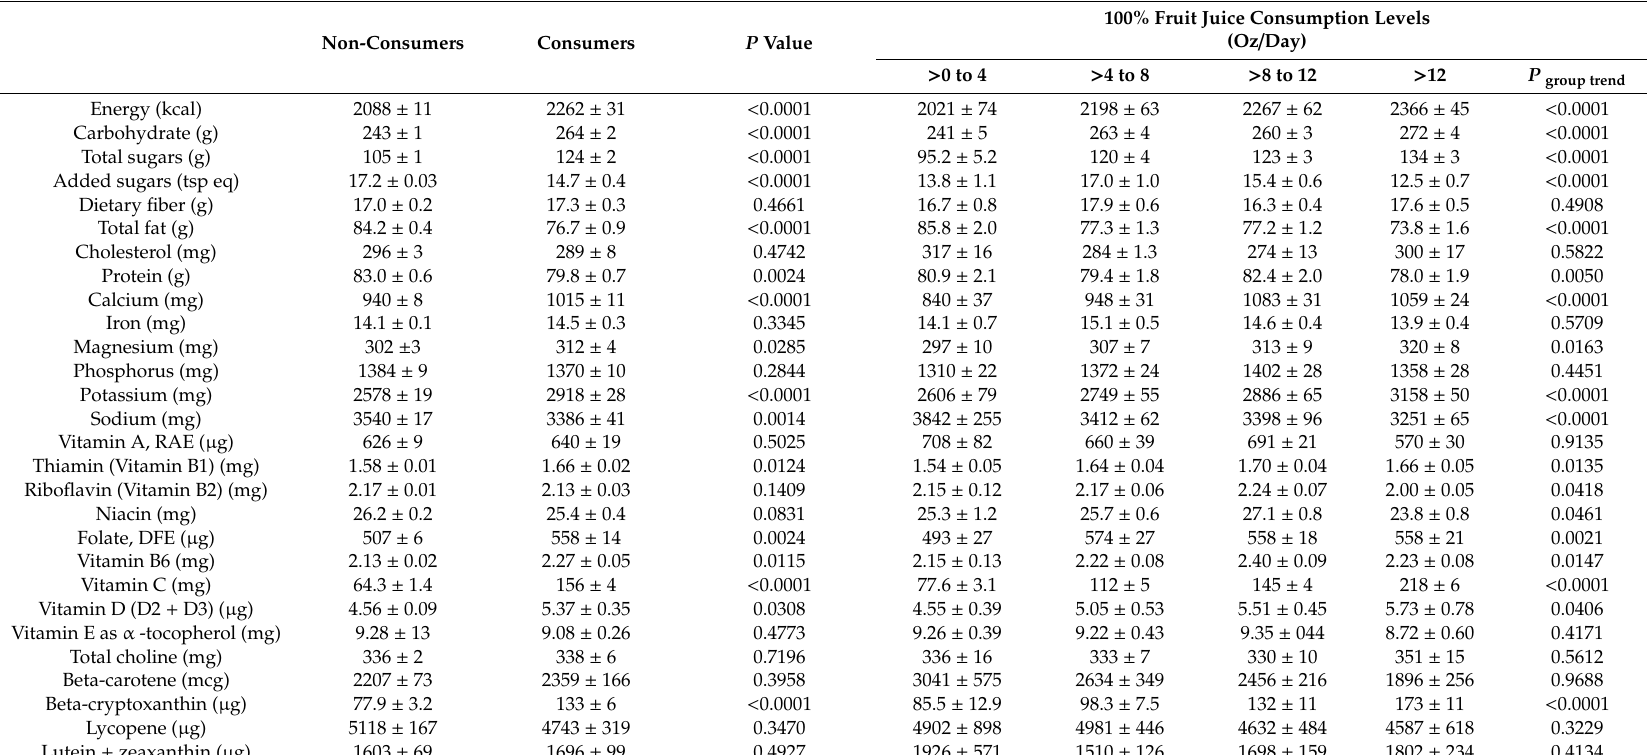
Table 3. Energy and nutrients intake associated with 100% fruit juice consumption in adults (19 + years of age, n = 9152)—NHANES 2013–2016 *. Non-Consumers